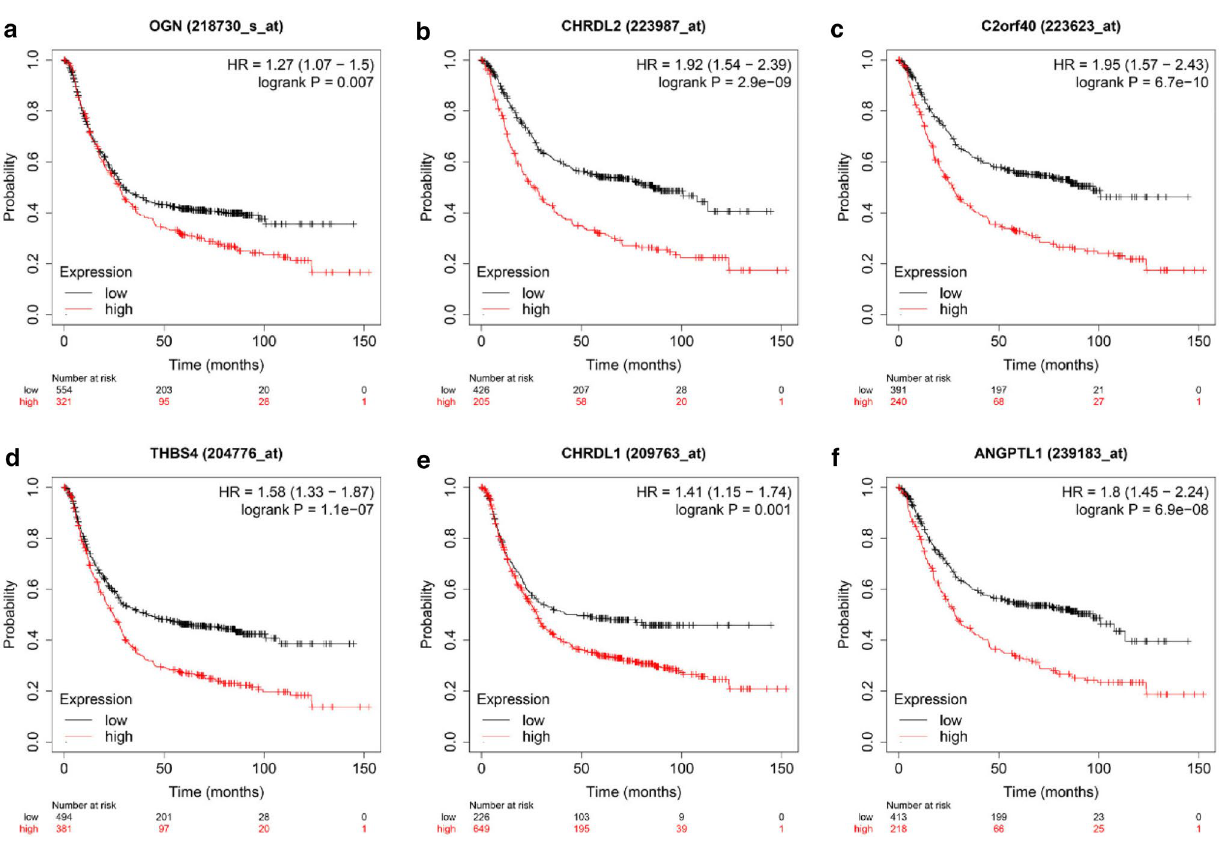
Fig. 2 Overall survival analysis of six hub genes in GC patients. Survival curves for high and low expression of OGN, CHRDL2, C2orf40, THBS4, CHRDL1, and ANGPTL1 in GC based on the Kaplan–Meier plotter database